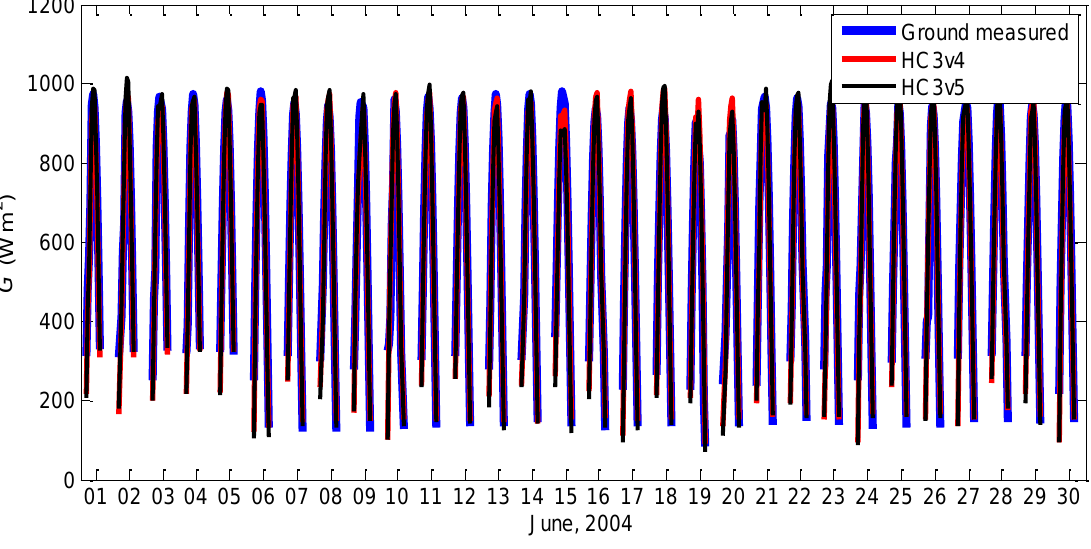
Figure 7. Time series of the ground measured, HC3v4 and HC3v5 GHI under all-sky conditions for the month of June, 2004 for the Arish station. Table 7. Validation of the clearness index KT under all-sky conditions, the best values for each station are in